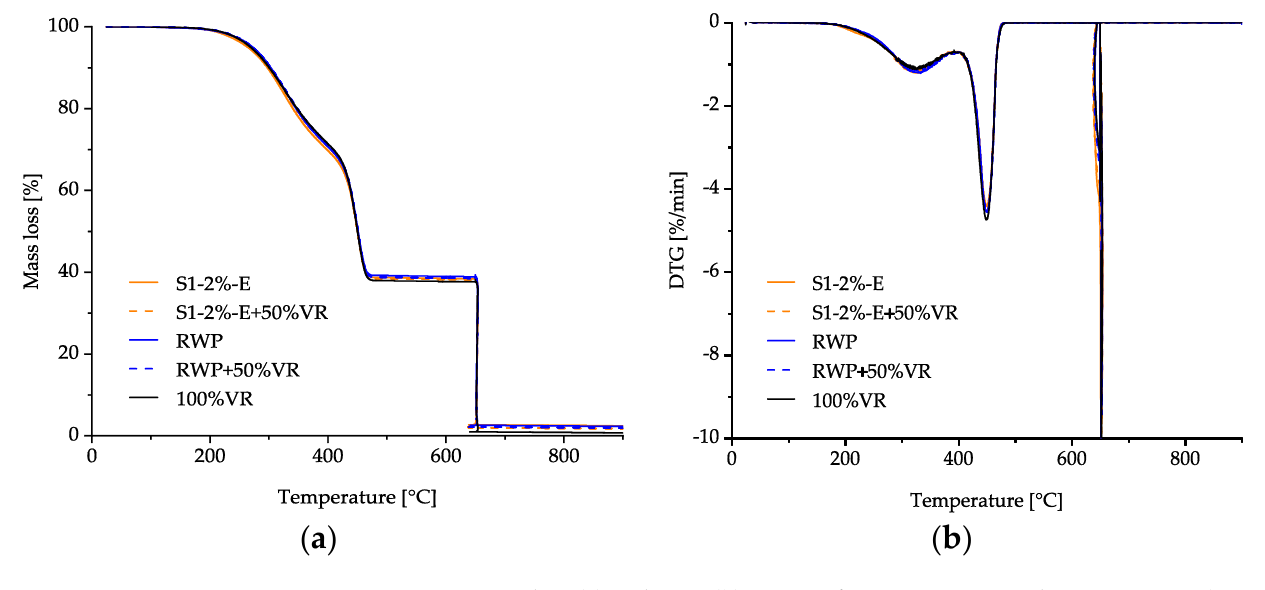
Figure 12. TGA mass loss ( a ) and DTG ( b ) curves of 100%VR, untreated RWP, S1-2%-E (50 rpm, 4.5 gpm), and virgin rubber blends with 50 wt% RWP and S1-2%-E (50 rpm, 4.5 gpm).